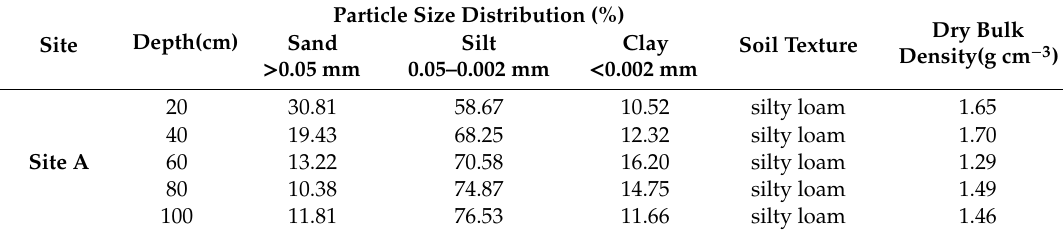
Table 4. Soil texture of experimental